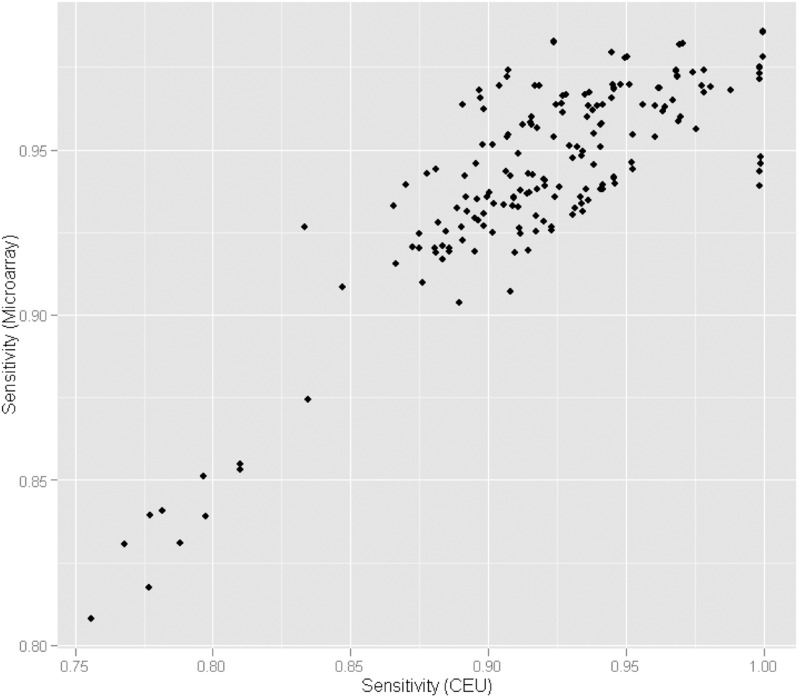
Correlation between sensitivity estimates from microarray data and using CEU population frequencies. Each point represents the sensitivity value obtained for individuals and analysis pipelines